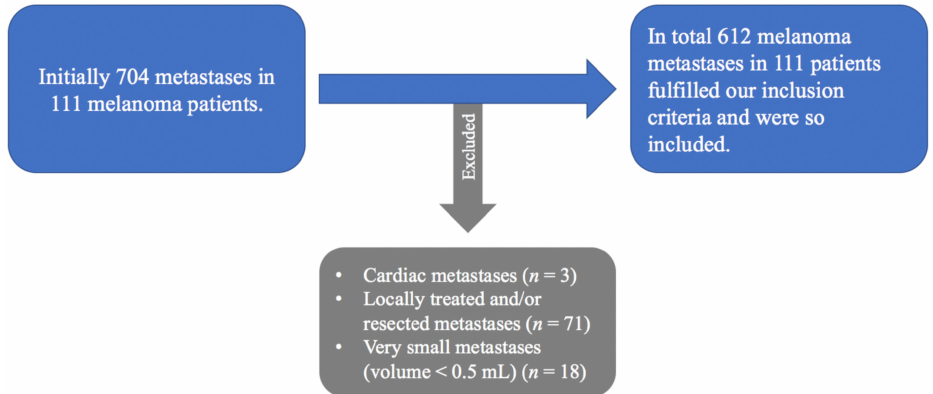
Figure 1. Exclusion criteria. In order to optimize the accuracy and also the reproducibility of the measurements using a manual 3D-contouring tool in accordance with the aim of the investigation 92 melanoma metastases were excluded. In total, 612 melanoma metastases fulfilled our